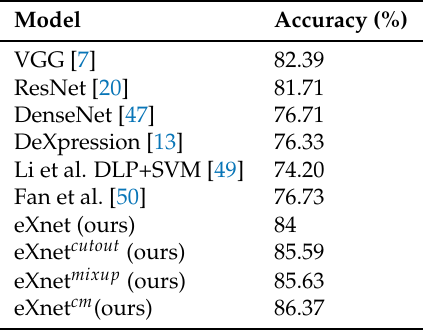
Table 6. Comparison of eXnet with benchmark networks on the RAF-DB dataset.